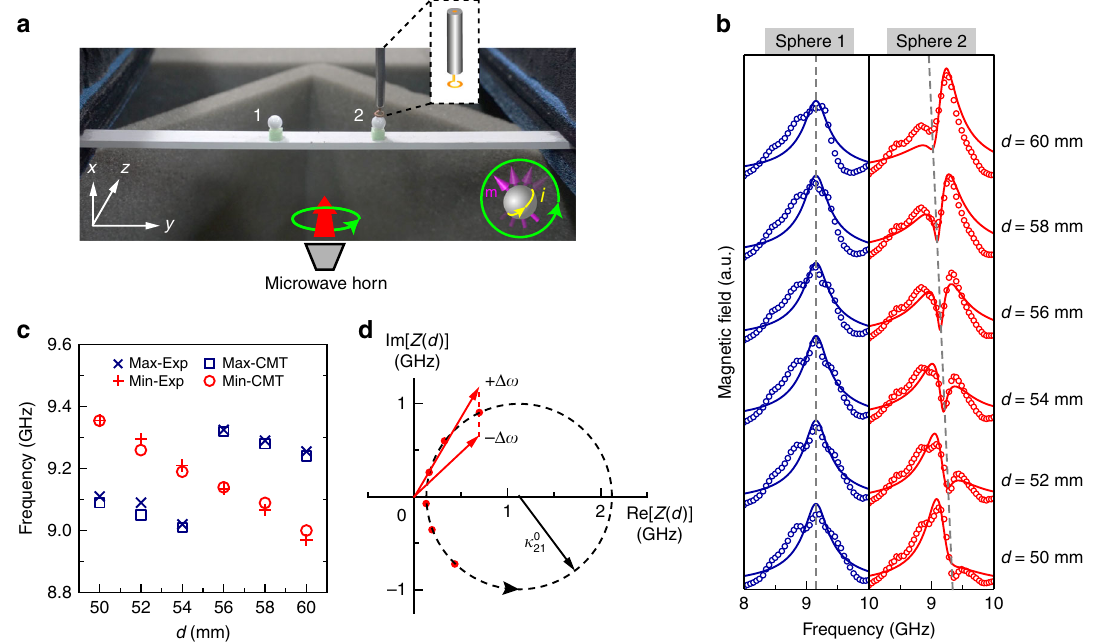
Fig. 5 Microwave demonstration of the exceptional point. a Photograph of the experimental setup. Two identical dielectric spheres were placed on a dielectric strip waveguide with the gap distance controlled by a foam spacer. The spheres have diameters of 5.56 mm. A probe measured the magnetic fi eld near the spheres under circular polarisation excitation. The inset in the right corner shows the chiral magnetic dipole mode. b Experimental results (symbols) and analytical fi tting results (solid lines) of the magnetic fi eld magnitude under left-handed circular polarisation excitation for different coupling distances d . The dashed lines mark the positions of the maxima (Sphere 1) and the minima (Sphere 2) of the fi eld. c The position of the maxima and minima in the resonance spectra of Sphere 2 in panel ( b ), showing a good match between the experimental (crosses) and analytical (circles and squares) results. d Evolution of Z ( d ) = Γ /2 − i κ 21 on the complex plane when d varies. The red symbols correspond to the cases in panel ( b ). The lengths of the red arrows denote the magnitude of | Γ /2 − i κ 21 ± i Δ ω |